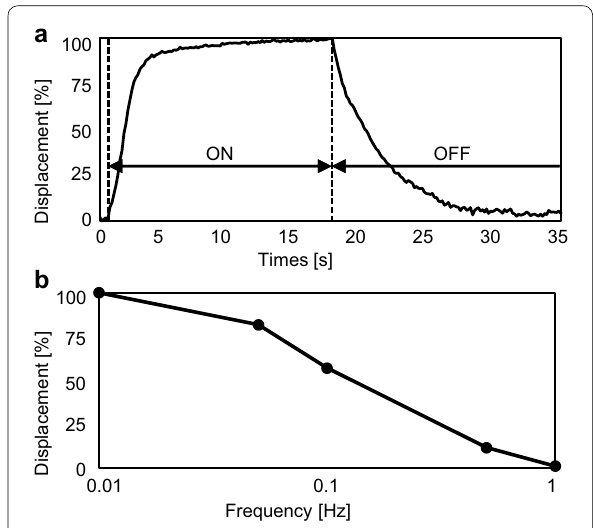
Fig. 11 Drive characteristics of the soft microrobot. a Step response, and b frequency